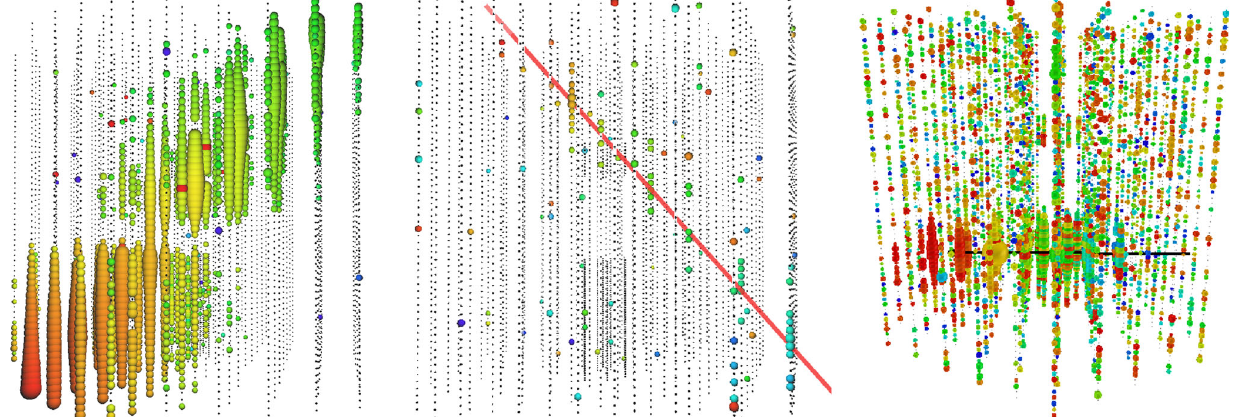
Fig. 36 Simulated event topologies for magnetic monopole of differ- ent velocities (see Fig. 2 for graphical event representation). Left panel: monopole traveling at 0 . 982 c from the bottom to the top of the detector [334].Thetotaltimeoftheeventis5000ns.Lesslighthasbeendetected in a horizontal plane [4] roughly at the half height of the detector due to dust in the ice. Middle panel: monopole at 0 . 3 c moving from the top of